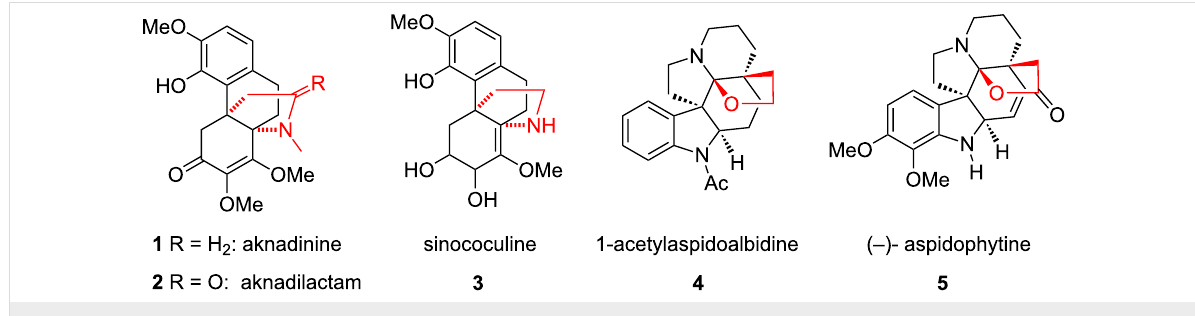
Figure 1: Various alkaloids containing propellane frame